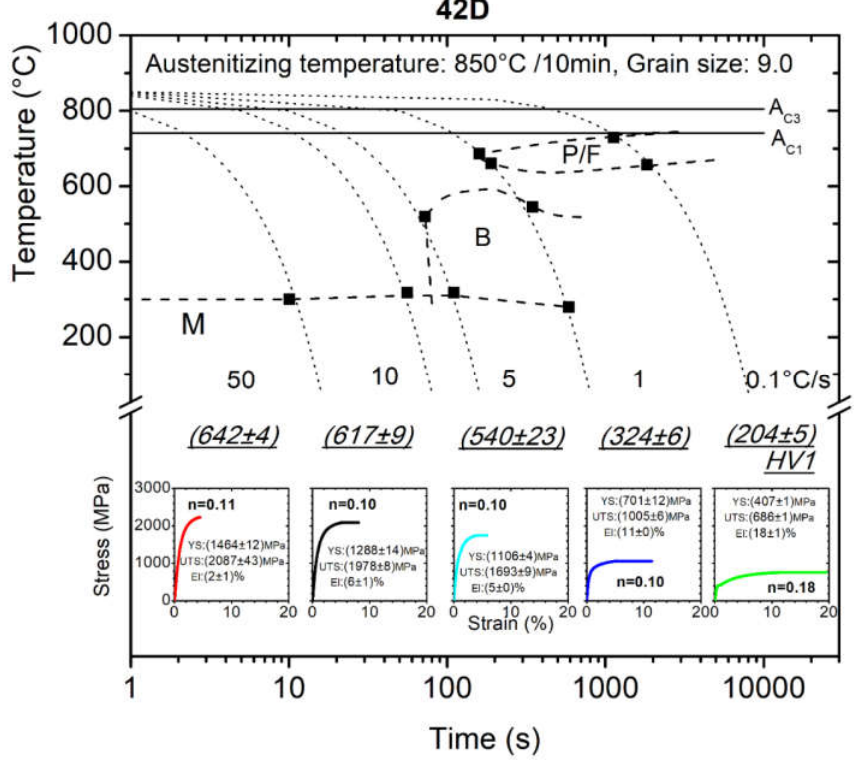
Figure 4. CCT diagram for 42D steel (P/F: perlite + ferrite, B: bainite, M: martensite). Table 2. Summary of phase transformation temperatures for individual cooling rates measured for 42C and 42D steel. (Ms: martensite start temperature, Mf: martensite finish temperature, B: bainite, P: perlite).